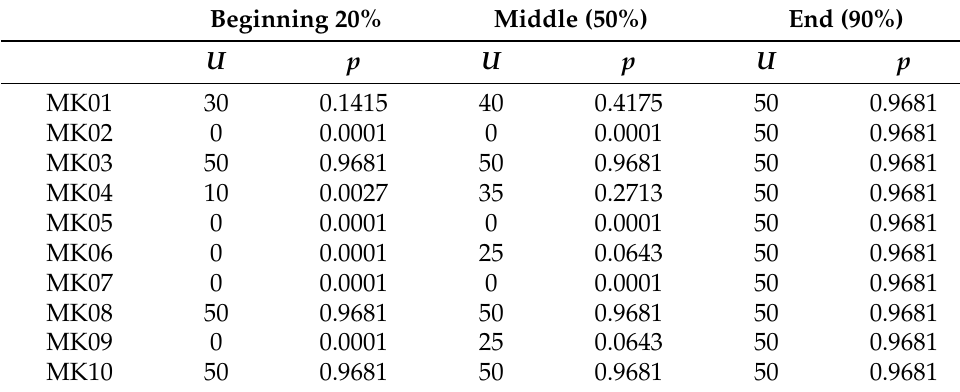
Table 13. Results of two-tailed Mann–Whitney tests.